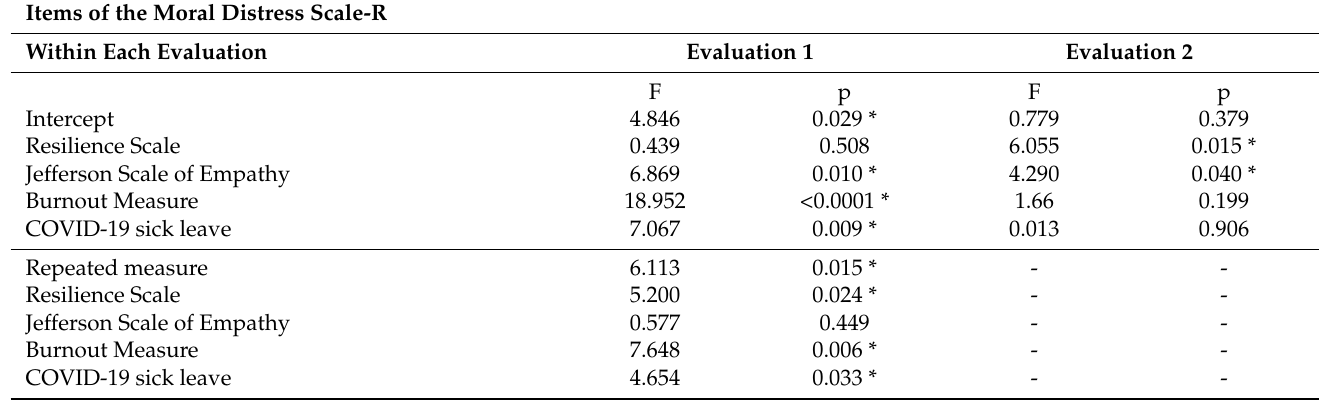
Table 5. Results of the multivariate analysis of covariance on the Moral Distress Scale -R score of 108 physicians between the two evaluations and within each